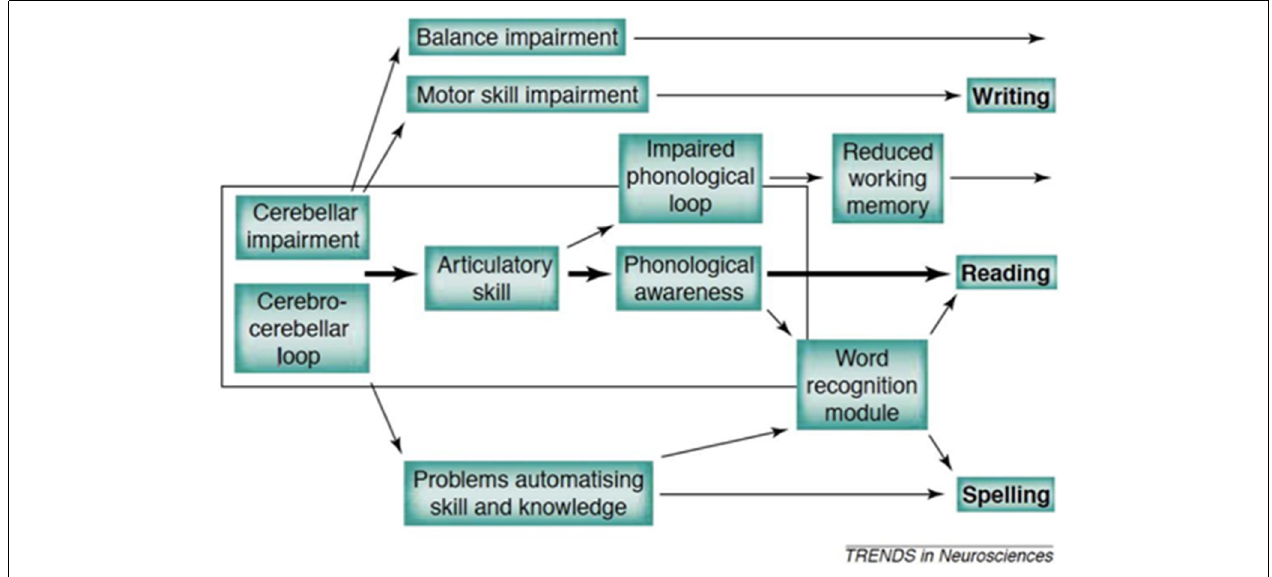
FIGURE 1 | The developmental causal chain (Nicolson et al.,